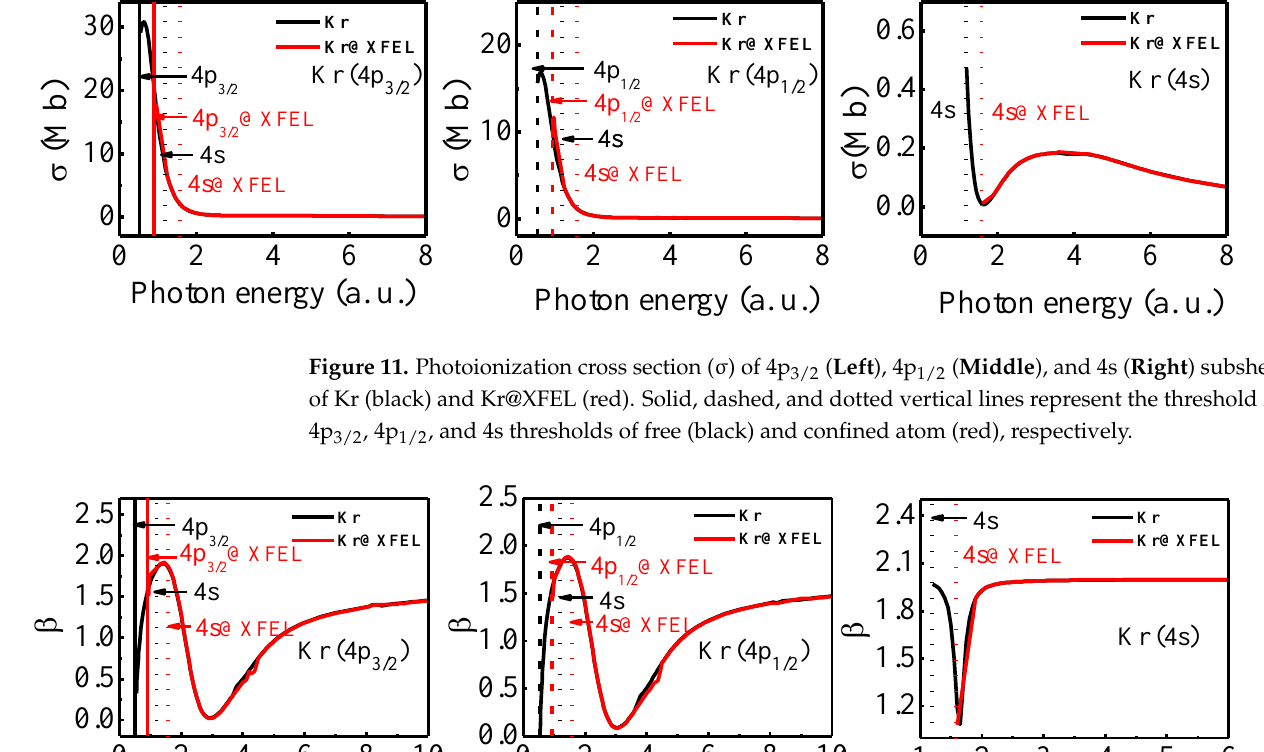
Photon energy (a. u.) Figure 13. Time delay (τ) of 4p 3/2 (Left), 4p 1/2 (Middle), and 4s (Right) subshells of Kr (black) and Kr@XFEL (red). Solid, dashed, and dotted vertical lines represent the threshold for 4p 3/2 , 4p 1/2 , and 4s thresholds of free (black) and confined atom (red) respectively. The induced Cooper minimum in the 4 s subshell cross section manifests as a peak in the corresponding subshell’s time delay. As in the 4 p cases, the confinement vanishes the features of the Cooper minimum in the time delay, as the CM is absent in the Kr@XFEL case. Figure 14 shows the difference between 4 s and 4 p subshells’ time delay in the free and confined cases. Although experimental data on photoionization time delay in Kr are not available for comparison, we provide theoretical results for completion and as a refer- ence for experimentalists. Figure 14 shows that the 4 s electron takes a longer time than 4 p electrons near the 4 s threshold of the free Kr. Due to the effect of 4 s CM, the relative time delay is a maximum. The confinement modifies the time delay difference; the relative time delay attains a maximum near the 4 s threshold, and it decreases monotonically.